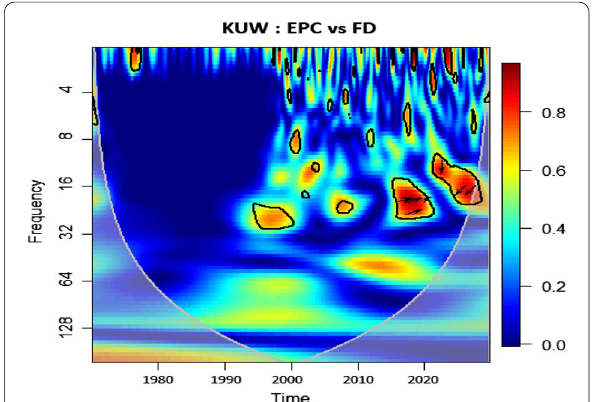
Fig. 6 Comovement between the electrical power consumption and financial development in Kuwait